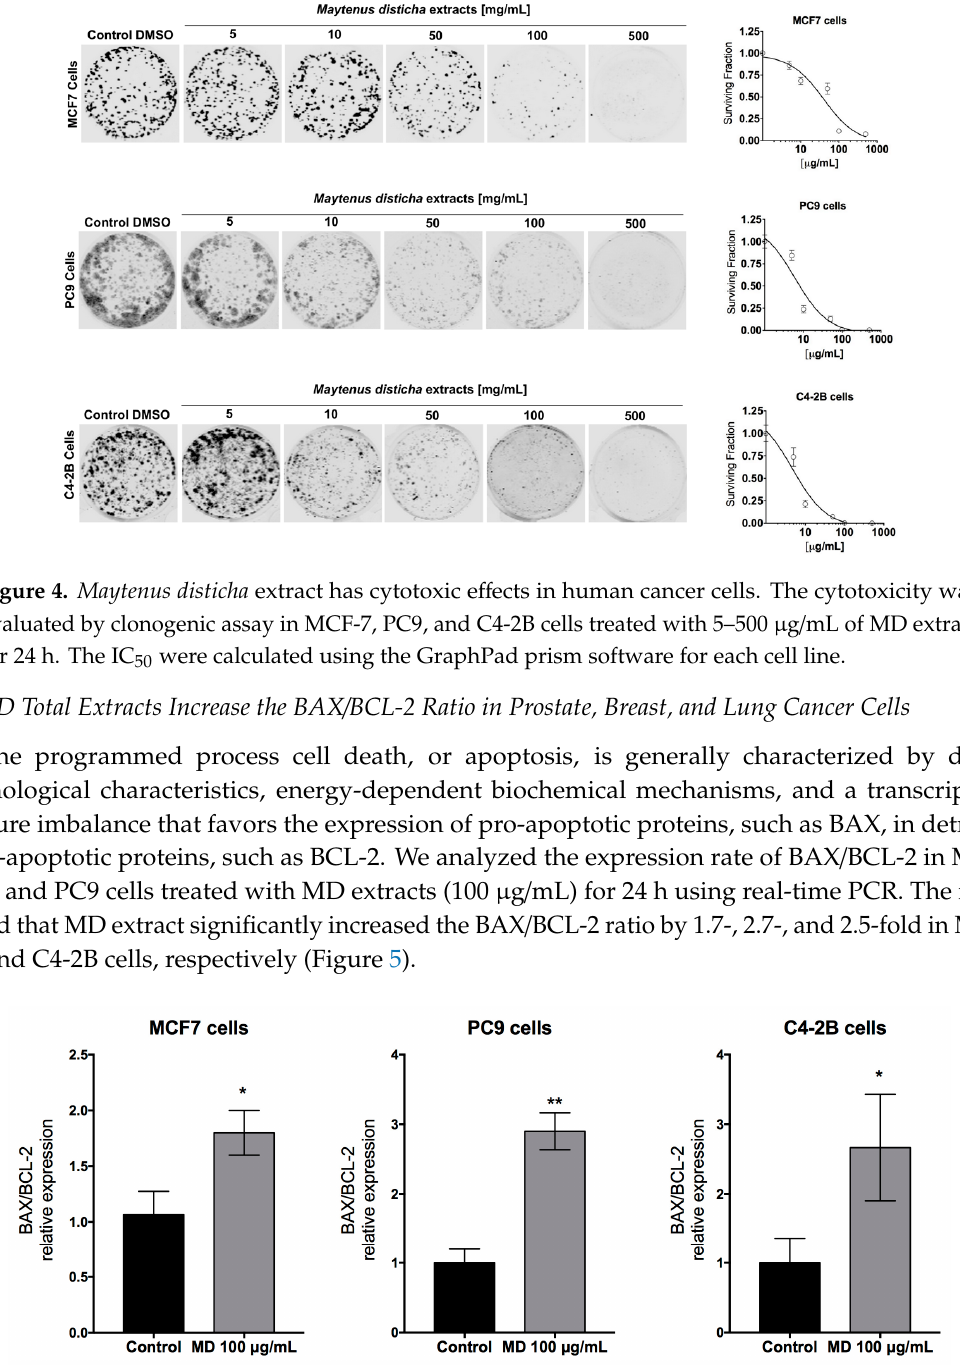
Figure 5. Maytenus disticha extracts increase the BAX / BCL2 ratio in breast, lung, and prostate cancer cells. MCF-7, PC9, and C4-2B cells were treated with 100 µ g / mL of MD extract for 24 h and the expression of BAX and BCL2 were analyzed by real-time PCR. The data represent the means ± S.D. of three independent experiments performed in triplicate, and statistically analyzed using one-way analysis of variance and Dunnett’s post-test; (** p ≤ 0.01, * p ≤